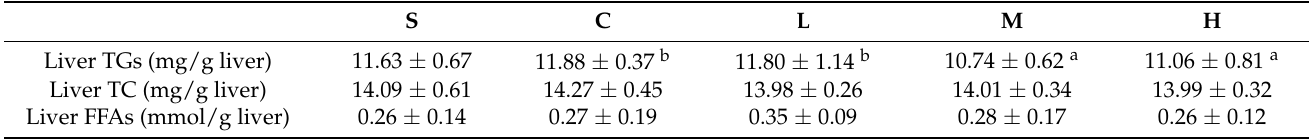
Table 8. Hepatic lipid variables after an ovariectomy and 8 weeks of a dietary intervention.